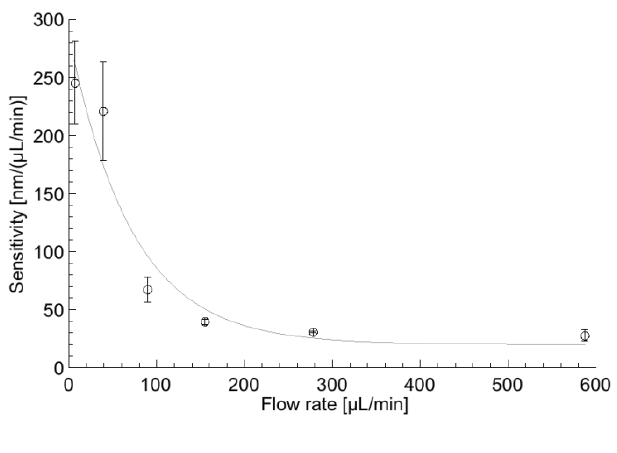
Figure 9. Sensitivity of the 11.2 µm thick SU-8 flow sensor with 112 holes of 10 × 10 µm 2 at variable flow